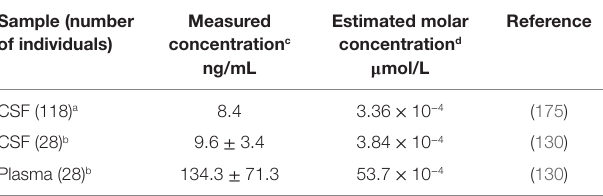
TABLe 4 | Human CSF and plasma cathepsin B concentrations. Sample (number Measured of individuals) concentration